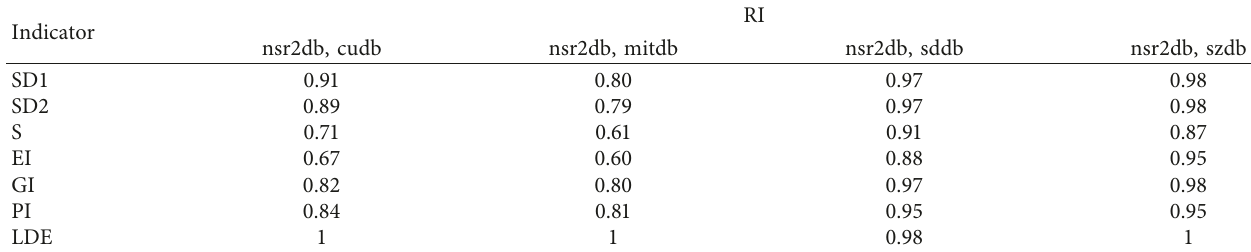
Table 3: The clustering results of SD1, SD2, S, EI, GI, PI, and LDE. Indicator